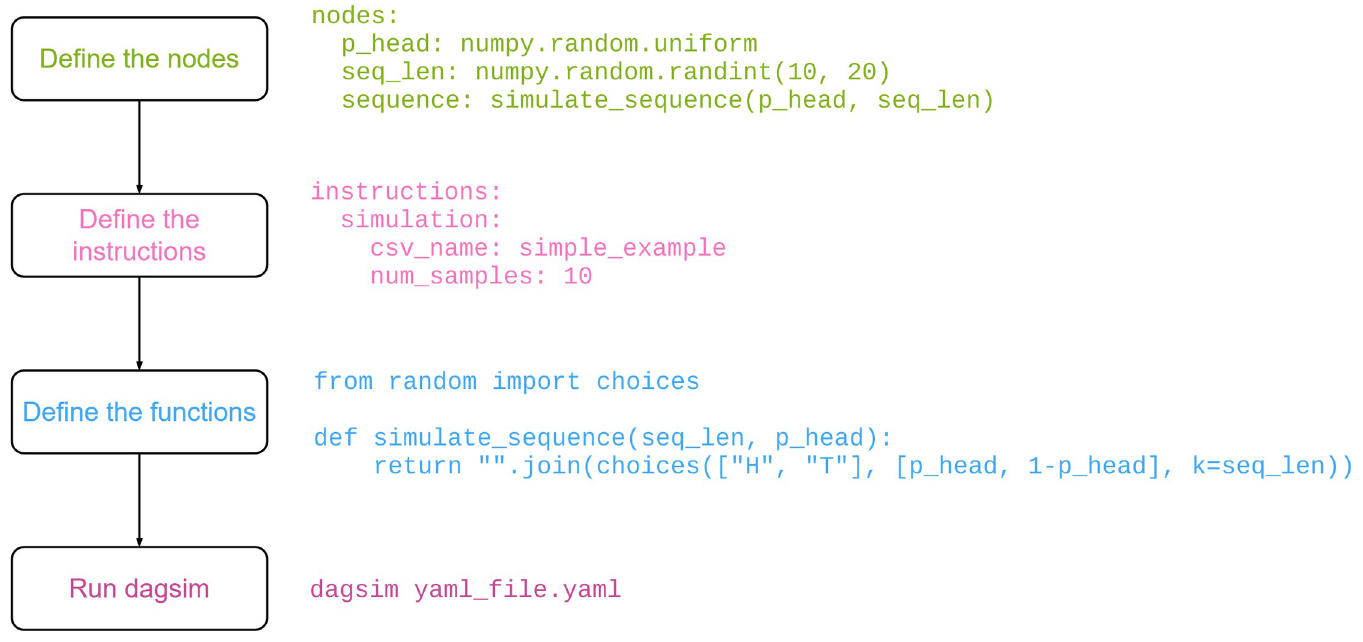
Fig 1. A typical workflow of simulating data using DagSim.